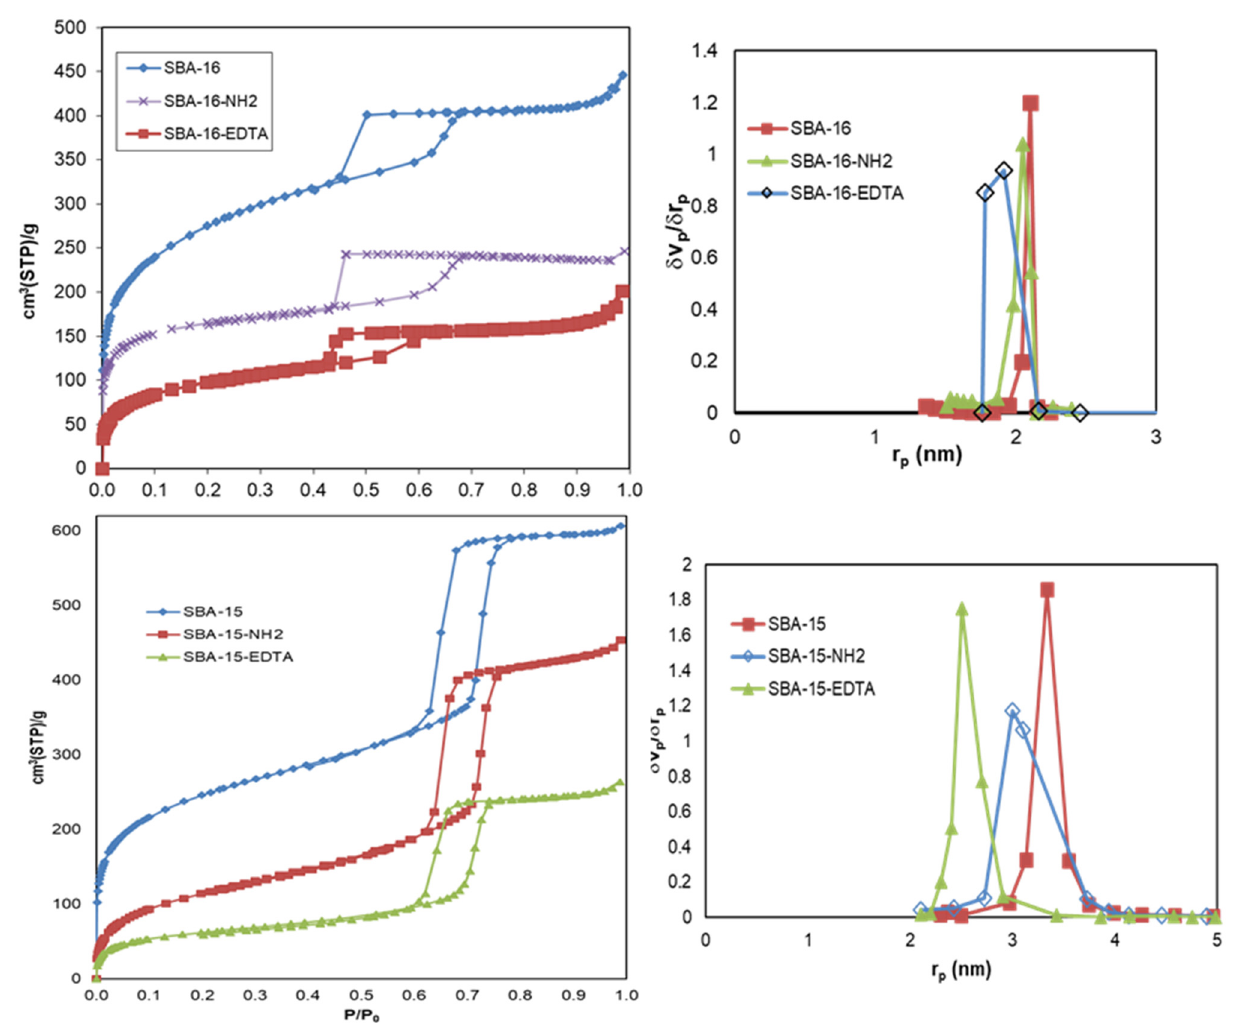
Figure 5. N 2 adsorption–desorption isotherms and pore size distribution of SBA-16 and SBA-15 be-